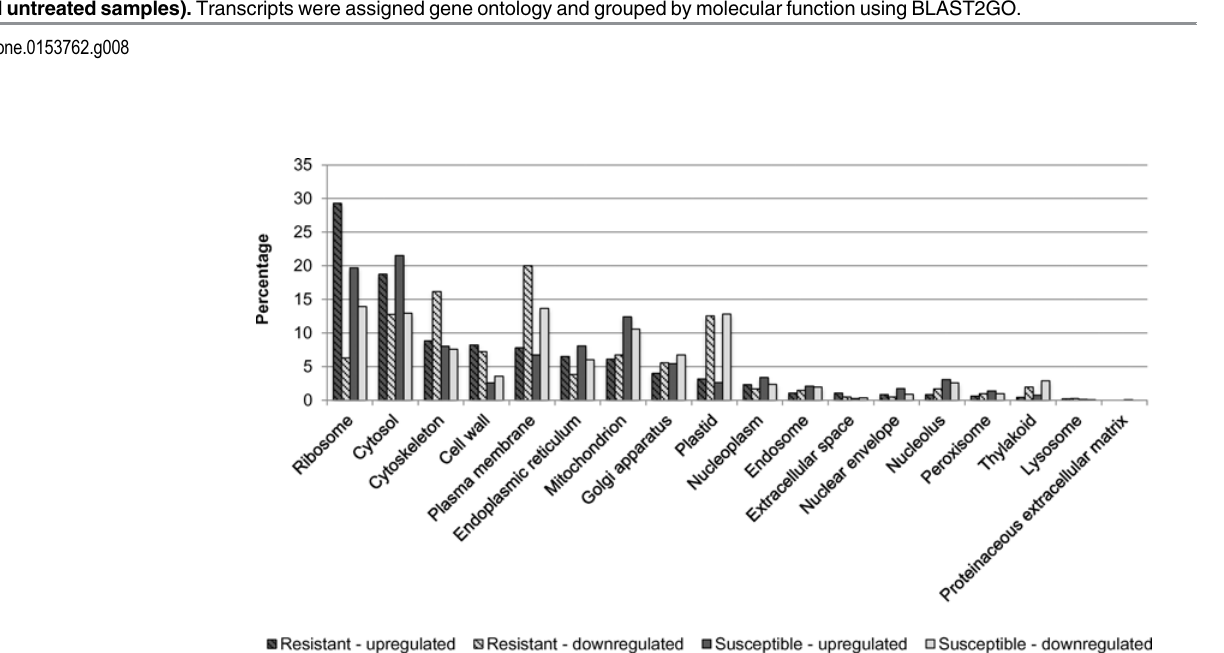
Fig 9. Percentage of upregulated and downregulated transcripts in the nickel- resistant and susceptible Betula papyrifera genotypes compared to control (nickel untreated samples). Transcripts were assigned gene ontology and grouped by cellular compartment using